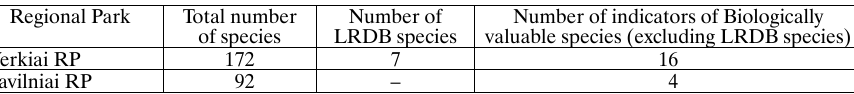
Data of diversity of lichens and allied fungi in Verkiai and Pavilniai regional